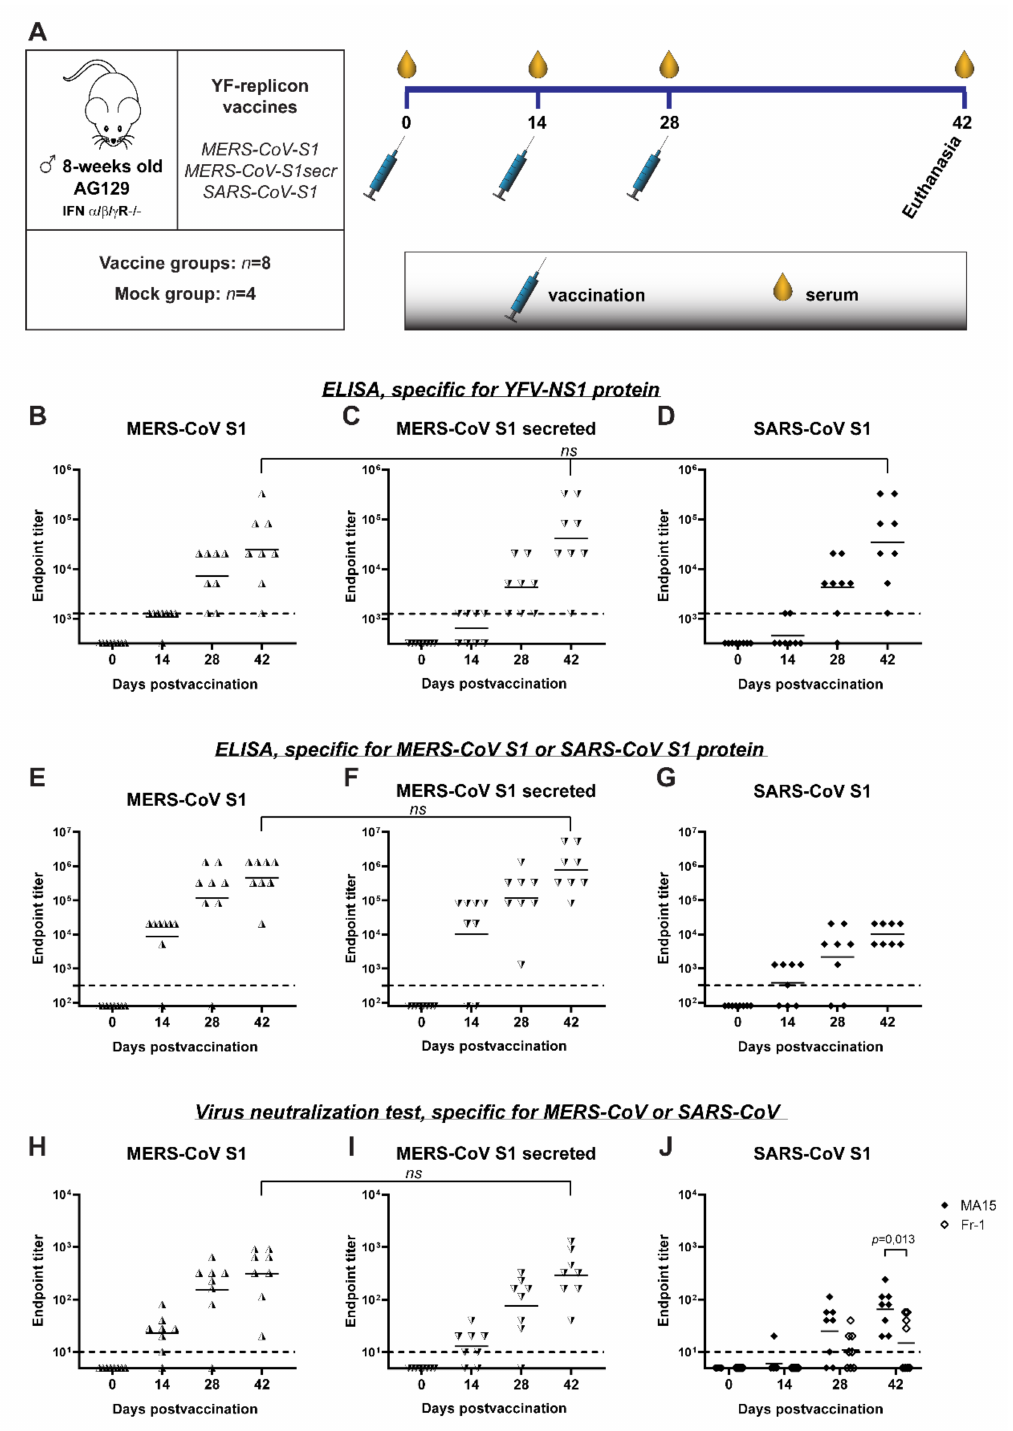
Figure 6. Humoral immune responses in mice, immunized with YF-replicons. ( A ) Schematic representation of the experimental design. ( B – D ) YFV-NS1-specific, ( E , F ) MERS-CoV S1-specific and ( G ) SARS-CoV S1-specific IgG antibodies, as measured by ELISA and expressed as endpoint titers. ( H – J ) Neutralizing titers against MERS-CoV ( H , I ) and against mouse-adapted SARS-CoV strain MA15 and a human-derived SARS-CoV strain Fr-1 ( J ) as measured by virus neutralization test and expressed as endpoint titers. The dotted lines indicate the lowest detectable titer (detection limit of the assay). All symbols represent individual titer values, and the geometric means are shown with horizontal lines. The YF-replicon used as a vaccine is shown above each graph. Statistical analysis was performed with nonparametric ANOVA ( B – D ) and with a t -test ( E , F , H – J ). Differences with p values ≤ 0.05 were considered significant and are shown where relevant. On the x-axis, days post-prime vaccination are